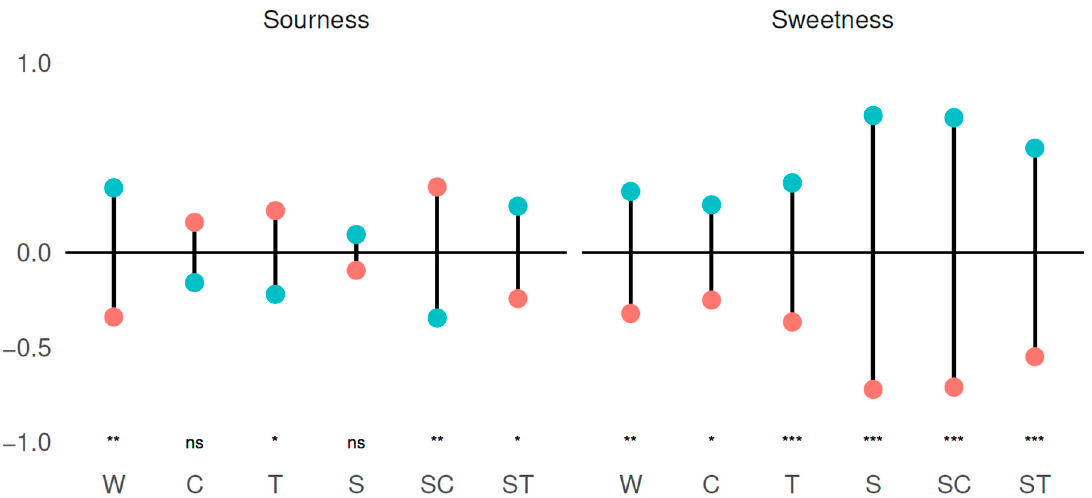
Figure 2. Deviations from means of ratings for sweetness intensity and sourness intensity for Chinese (red dots) and Danish (green dots) consumers, respectively. Samples are Water (W), Citric acid (C), Tartaric acid (T), Sucrose (S), Sucrose and Citric acid (SC), and Sucrose and Tartaric acid (ST). Significant differences are pairwise comparison of estimated marginal means corrected using Bonferroni corrections: ns = not significant, * < 0.05, ** < 0.01, *** < 0.001.